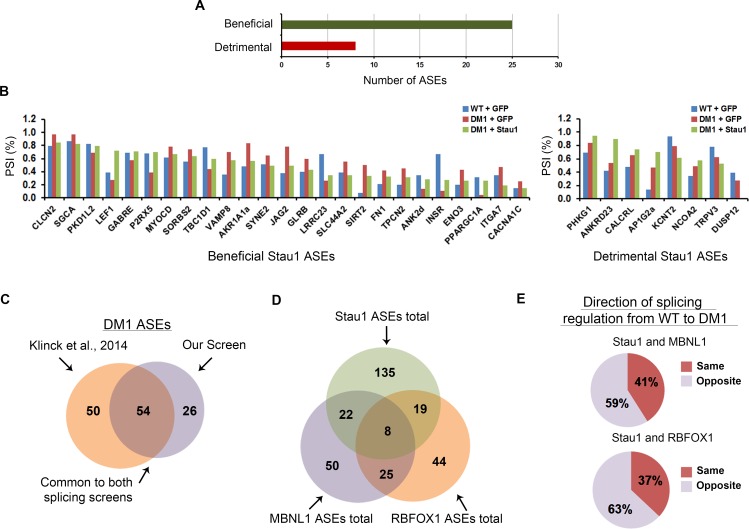
Stau1 overexpression regulates the alternative splicing of numerous ASEs which are both beneficial and detrimental in DM1 conditions.(A) A total of 33 ASEs were considered for this analysis based on the following criteria. First, ASEs that showed a ≥10% ΔPSI from WT to DM1 conditions were selected. From this, ASEs that showed a ≥10% ΔPSI with Stau1 overexpression were selected and identified as either beneficial or detrimental for the DM1 pathology (refer to results). (B) Bar graphs showing the specific ASEs that the overexpression of Stau1-HA under DM1 conditions either returned towards the WT splicing pattern (left bar graph) or continued towards a detrimental effect (right bar graph). (C-E) Comparison of the data obtained from the RT-PCR splicing screen presented here to that of Klinck et al., 2014. The threshold used by Klinck et al., was applied (≥5% PSI) to compare the 163 ASEs used in both screens (Refer to S1 Table). (E) The direction of splicing was determined by identifying whether modification of the splicing proteins (i.e. Stau1 and/or MBNL1/RBFOX1) shifted the splicing pattern of an ASE in similar directions, for example, modification of both splicing factors resulted in an increased splicing of the long isoform.